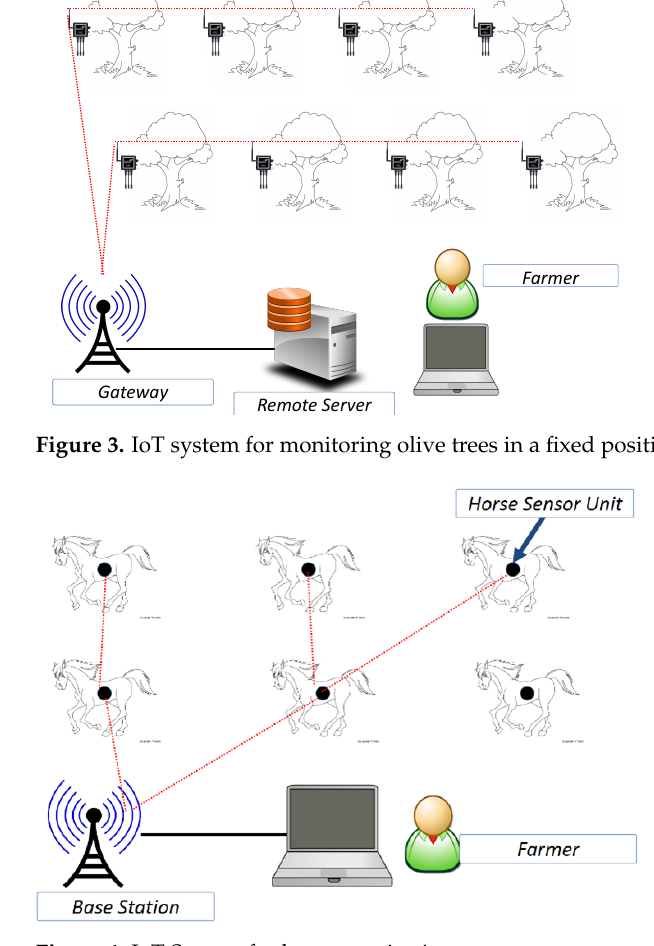
Figure 4. IoT System for horse